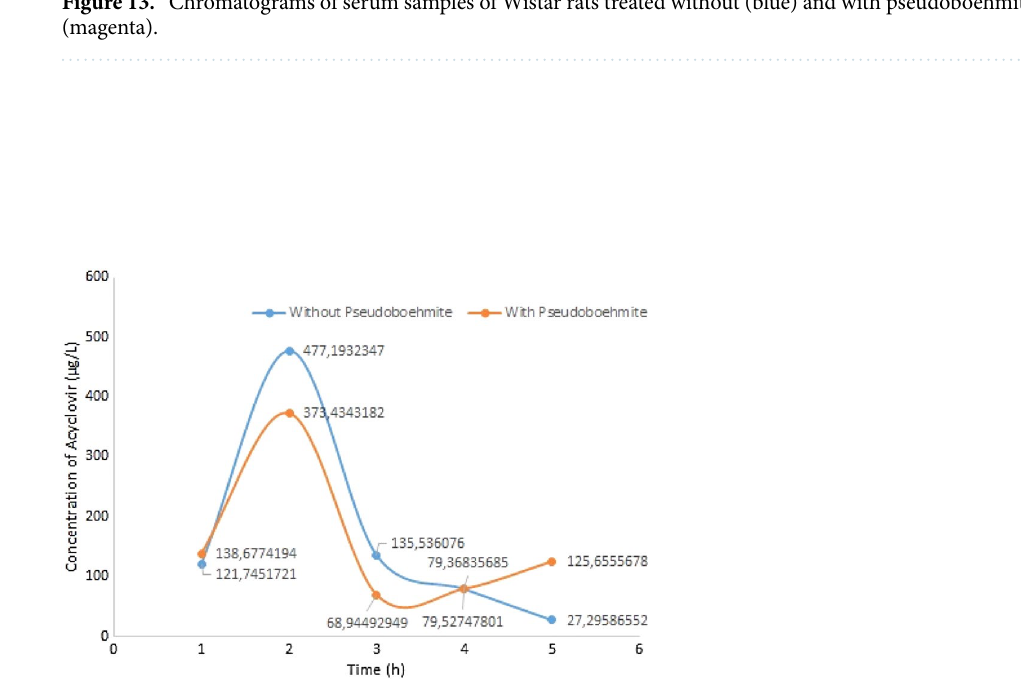
Figure 14. Acyclovir concentration in the blood of Wistar rats. Blue is without pseudoboehmite and orange is with